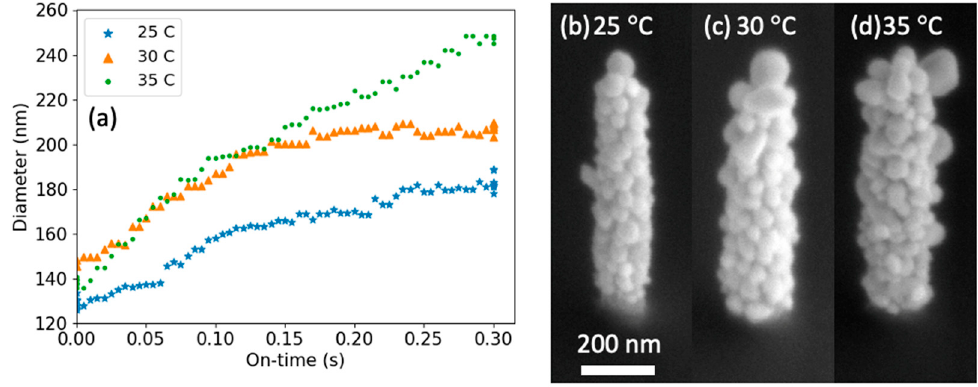
Figure 5. ( a ) A plot of the nanopillar diameters as a function of laser on-time at different crucible temperatures. ( b – d ) SEM images of the nanopillar after processing at ( b ) 25 °C, ( c ) 30 °C, and ( d ) 35 °C.